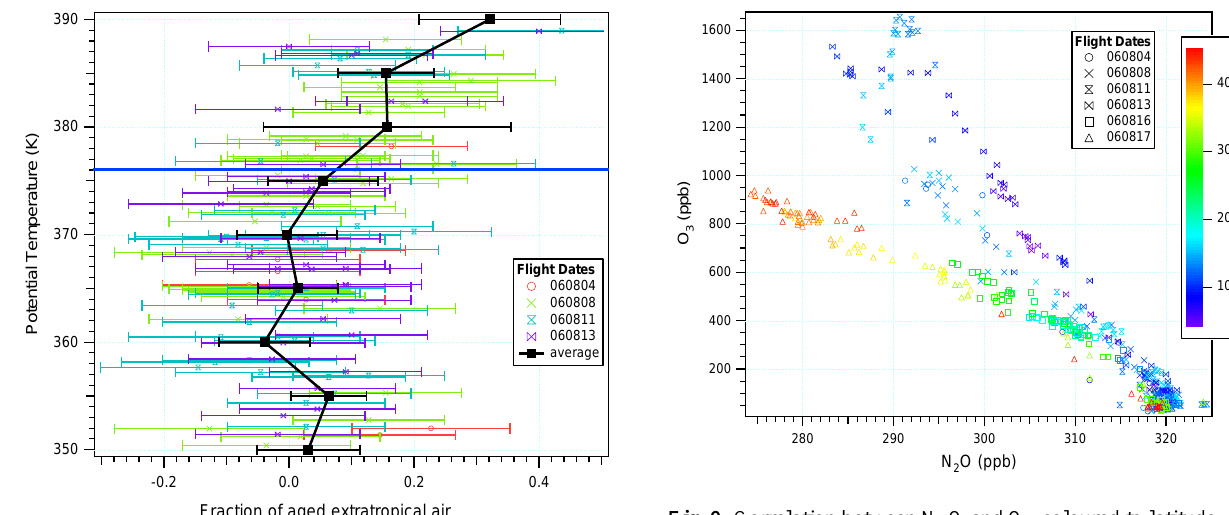
Fig. 9. Correlation between N 2 O and O 3 coloured to